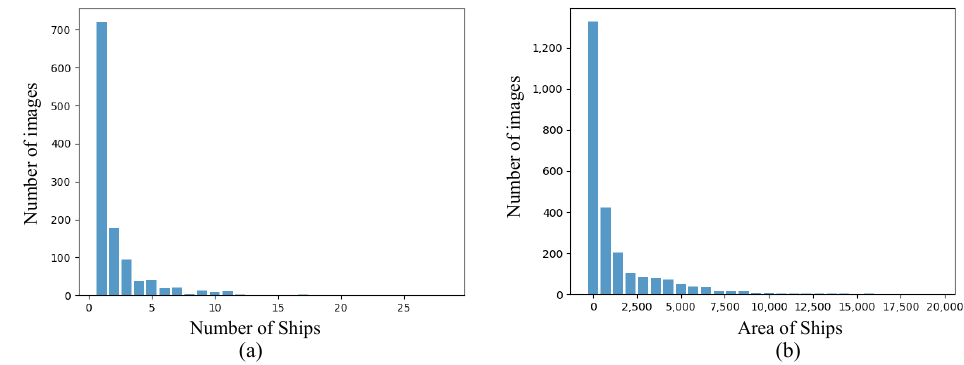
Figure 2. Statistics of the SSDD dataset. ( a ) is the number of images with regard to the number of ground-truth ships. ( b ) shows the number of ships with regard to the area of ground-truth